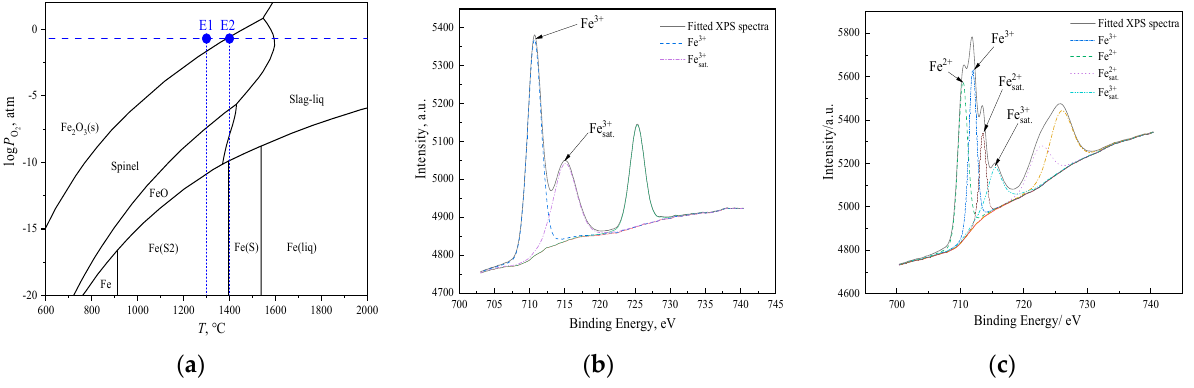
Figure 2. Determination of the Fe valance state in air at 1300 °C and 1400 °C. ( a ) Fe − O stable phase diagram; ( b ) Sample B6 at 1300 °C; ( c ) Sample B6 at 1400 °C.